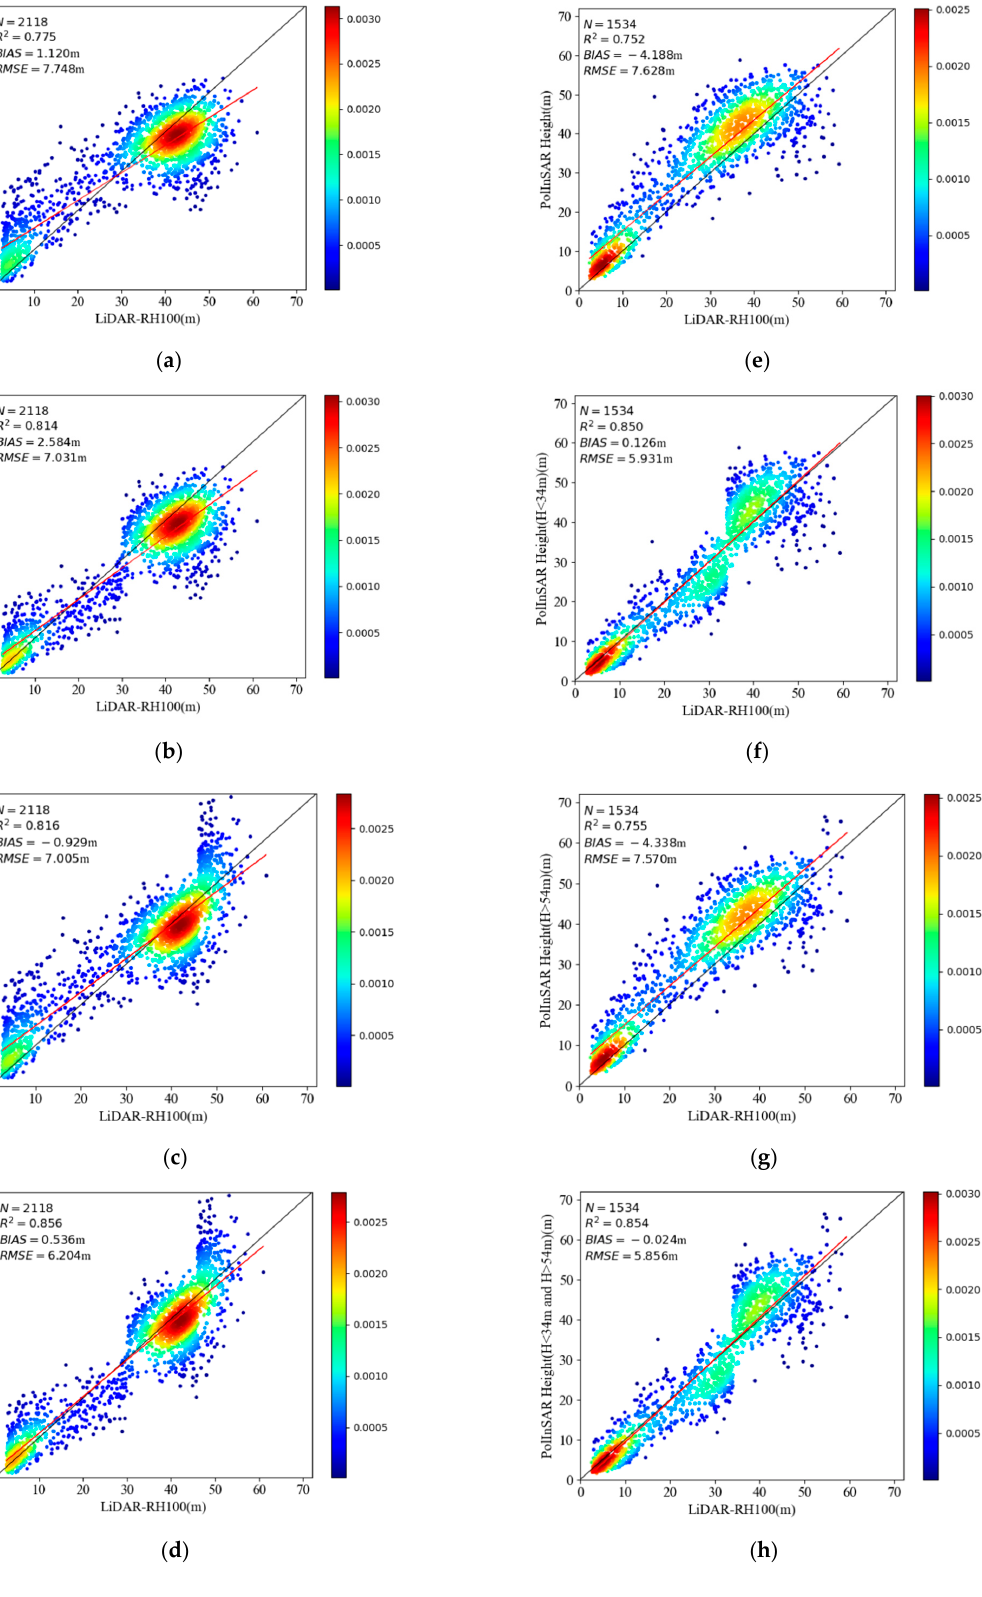
Figure 9. Scatter plots illustrating the validation of results corrected to the reference height threshold for the ( b – d ) Lope test area and ( f – h ) Pongara test area. ( a , e ) are the results of the RVoG model before correction for the Lope and Pongara test areas, respectively.